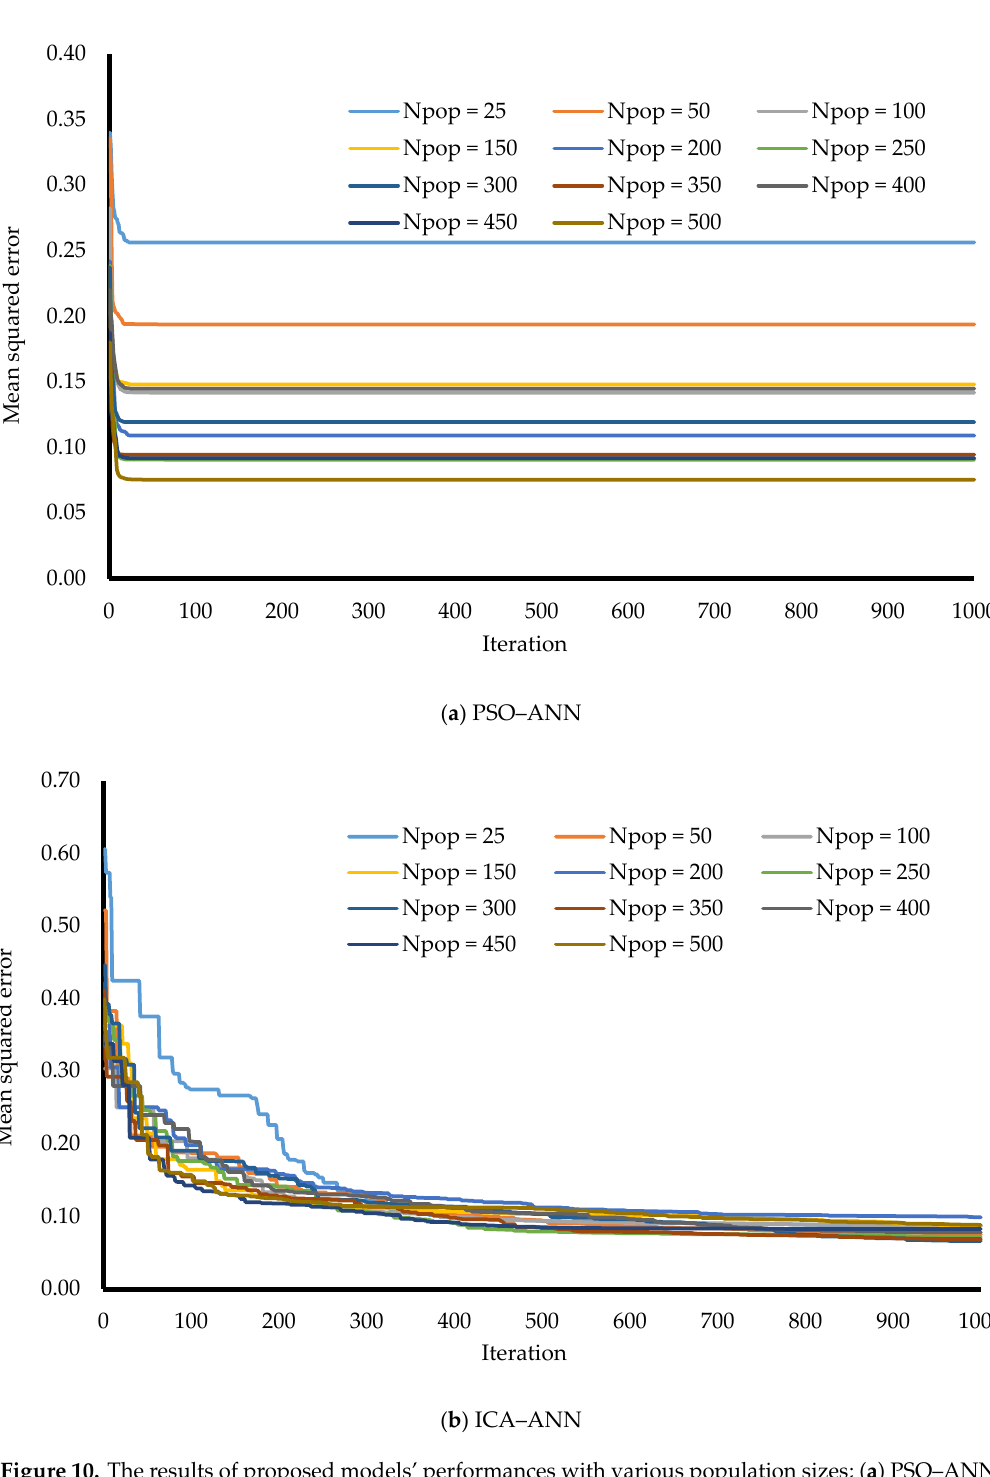
Figure 10. The results of proposed models ’ performances with various population sizes; ( a ) PSO – ANN, ( b ) ICA – ANN.